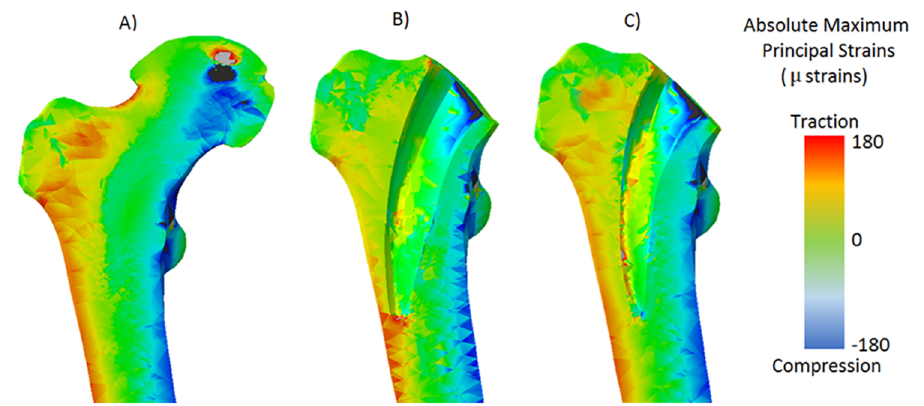
Fig 8. Comparison of the absolute maximum principal strain distribution between intact bone model (a), the one implanted with the original stem (b) and the new design (c).